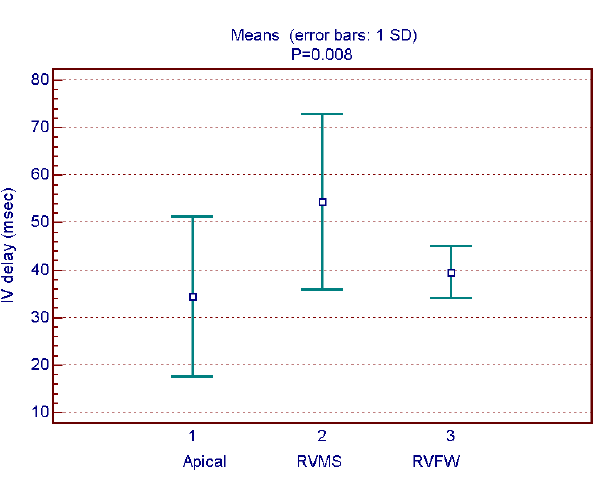
Fig. 6 - Intraventricular delay and lead position. IV=interventricular; RVFW=right ventricle free wall;